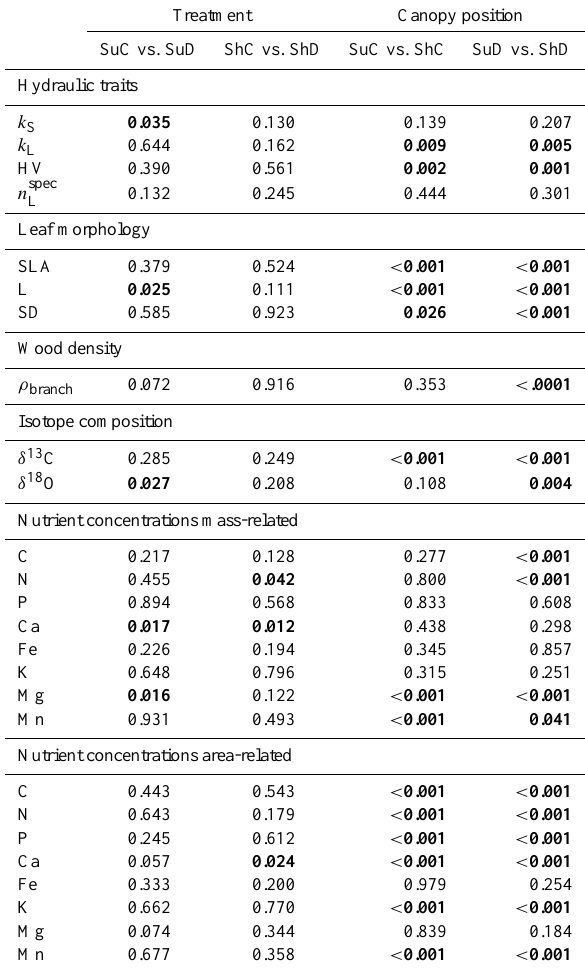
Table 6. P-values of a linear mixed effects model on significant dif- ferences between control and drought plots (Treatment) or sun and shade crown (Canopy position) in C. acuminatissima for 25 mor- phological, chemical and functional variables investigated. The la- bels denote Sun Control (SuC), Shade Control (ShC), Sun Drought (SuD) and Shade Drought (ShD). Significant differences ( p ≤ 0 . 05) are printed in